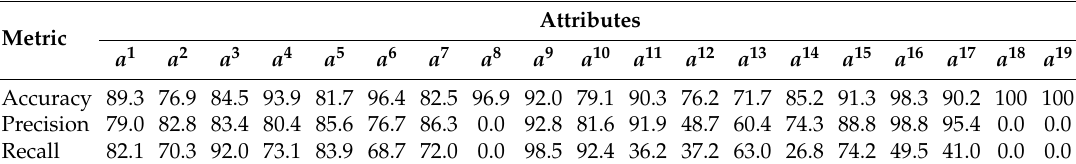
Table 13. The accuracy, precision, and recall [ % ] for the attributes on the test dataset.